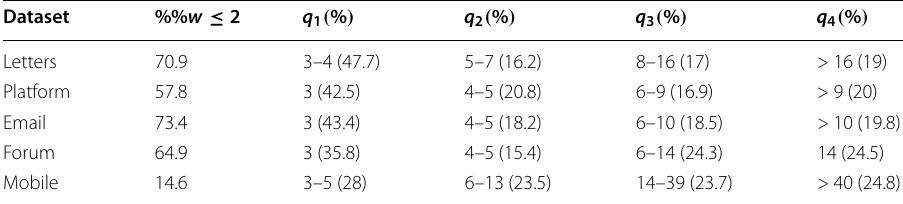
The first numerical column contains the fraction of links that have either one or two contacts, and which were thus not used to compute temporal features. The latter columns contain the composition of each quartile, including their ranges of contacts and in brackets the percentage of links in that category